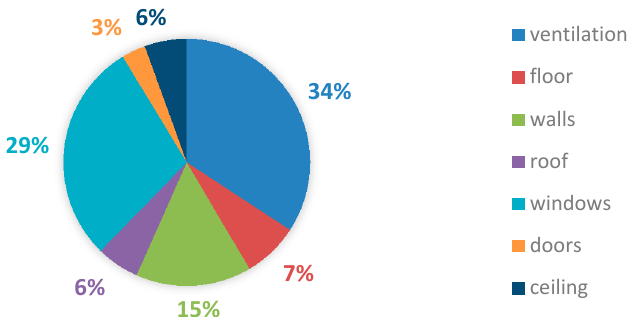
Figure 7. The seasonal share of heat losses in the total amount of heat losses of the building.